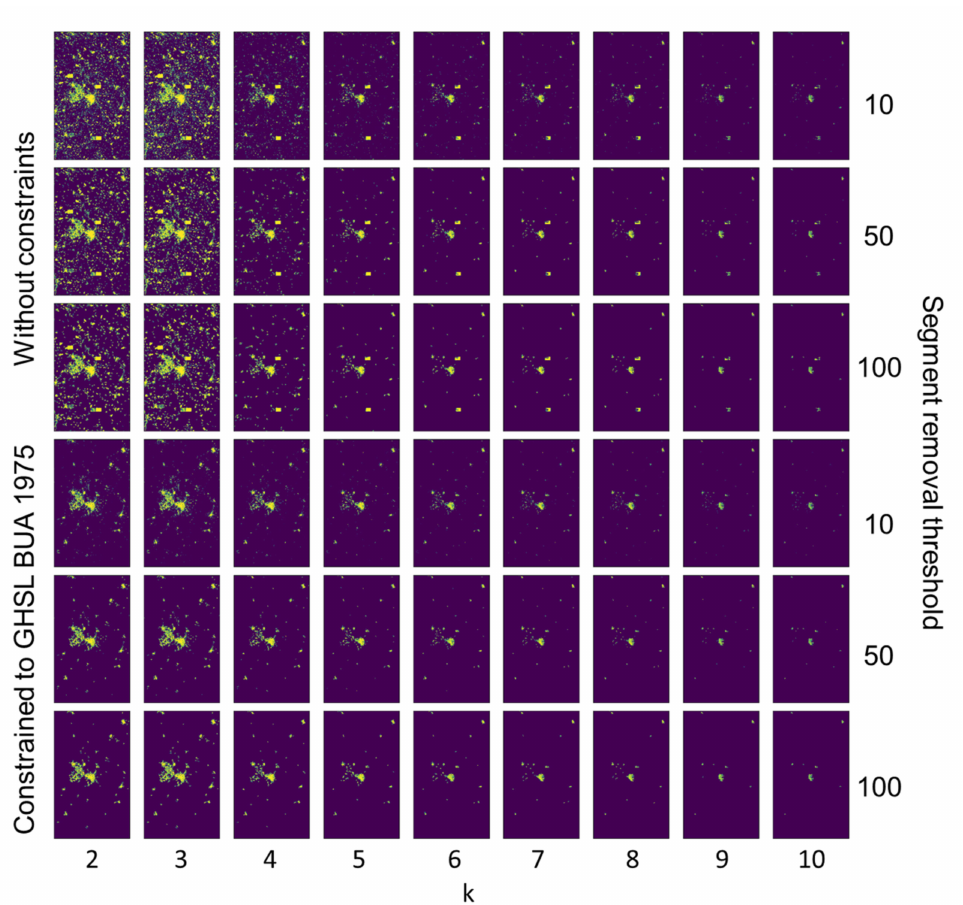
Figure A5. Illustrating the effects of spatially constraining the extraction results to the GHSL built-up areas in 1975, the different clustering granularity k, and the threshold used for